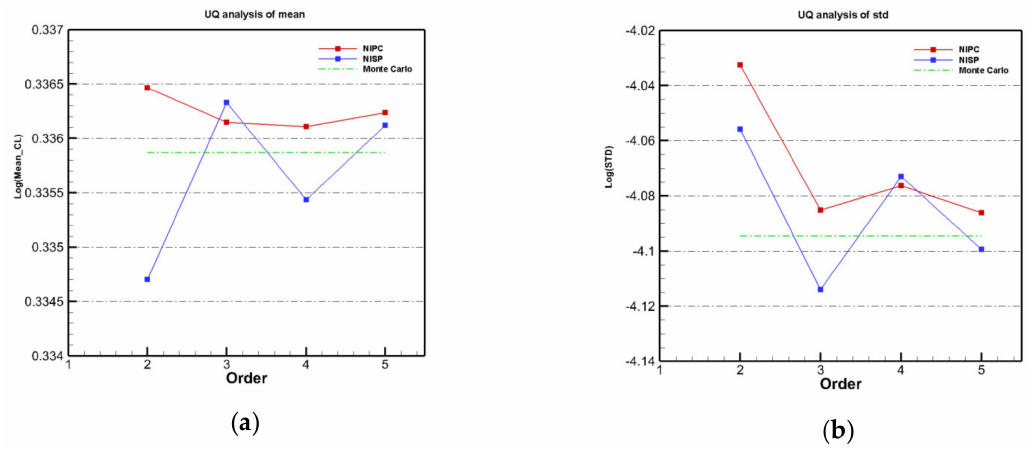
Figure 9. The mean and standard deviations of the lift coefficient of the three methods for Orders 2–5: ( a ) mean value; and ( b ) standard deviation.